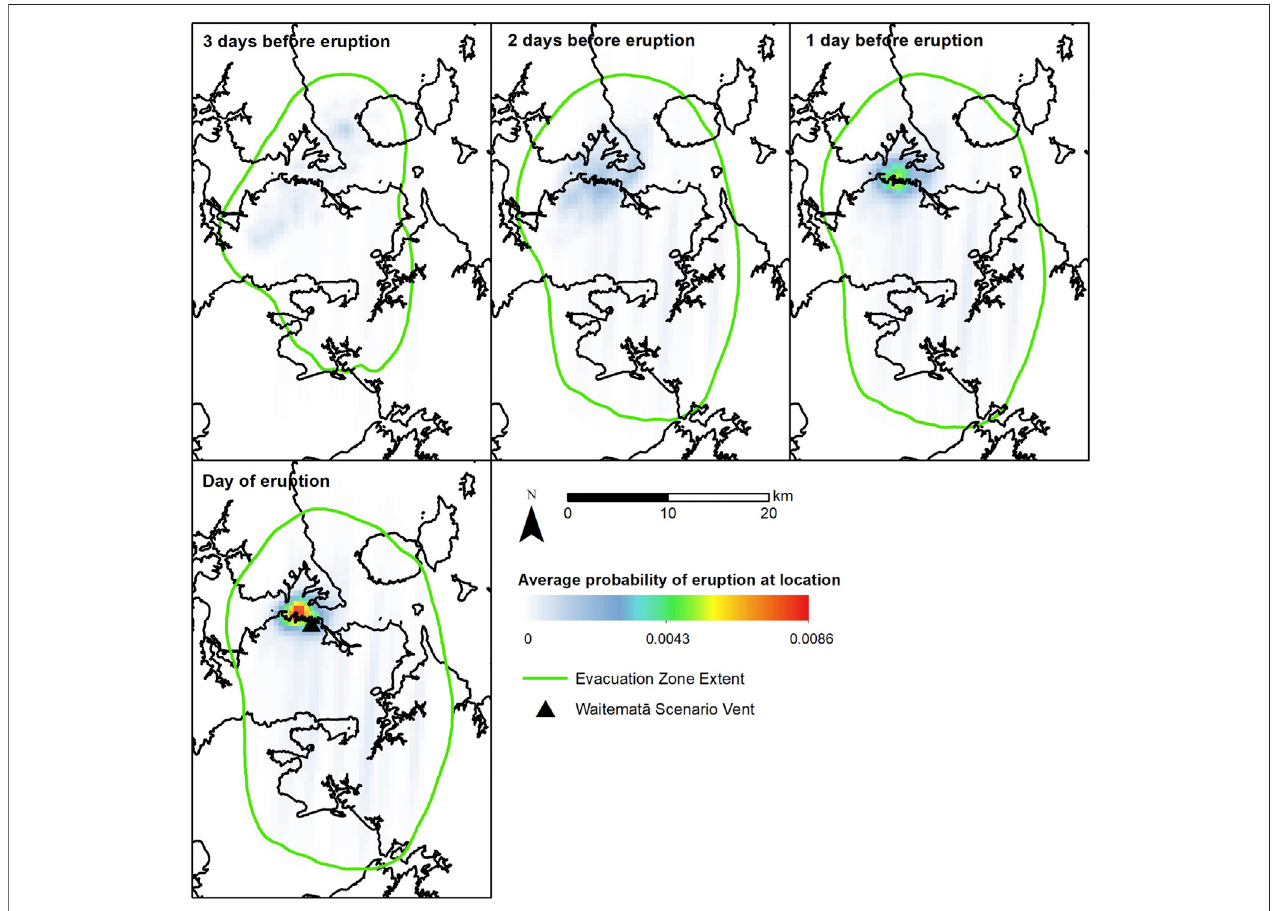
FIGURE 10 | Spatial distribution of absolute eruption probabilities for the Waitemat ā scenario from BETEF_AVF with the Bebbington 2013 LSCV prior vent model for selected days leading up to the eruption. The green contour encompasses the evacuation zone extent based on cost-bene fi t analysis.